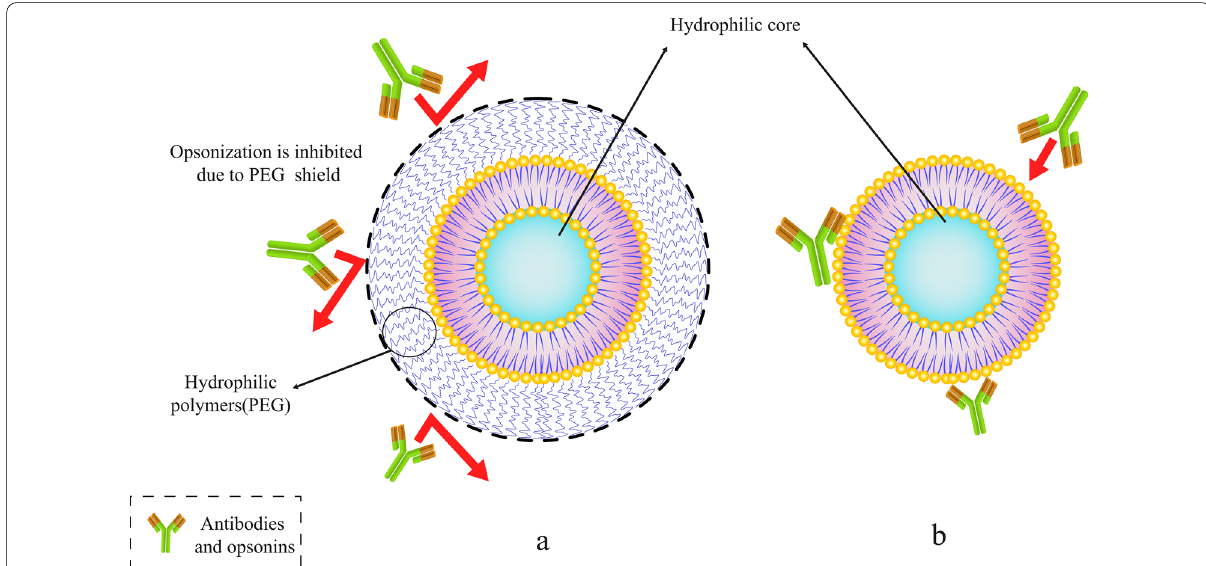
Fig. 5 Conjugating a specific polymer such as polyethylene glycol (PEG) to liposomes. a PEGylated liposomes with PEG polymer molecules shield. b Conventional liposome trapped by antibodies and